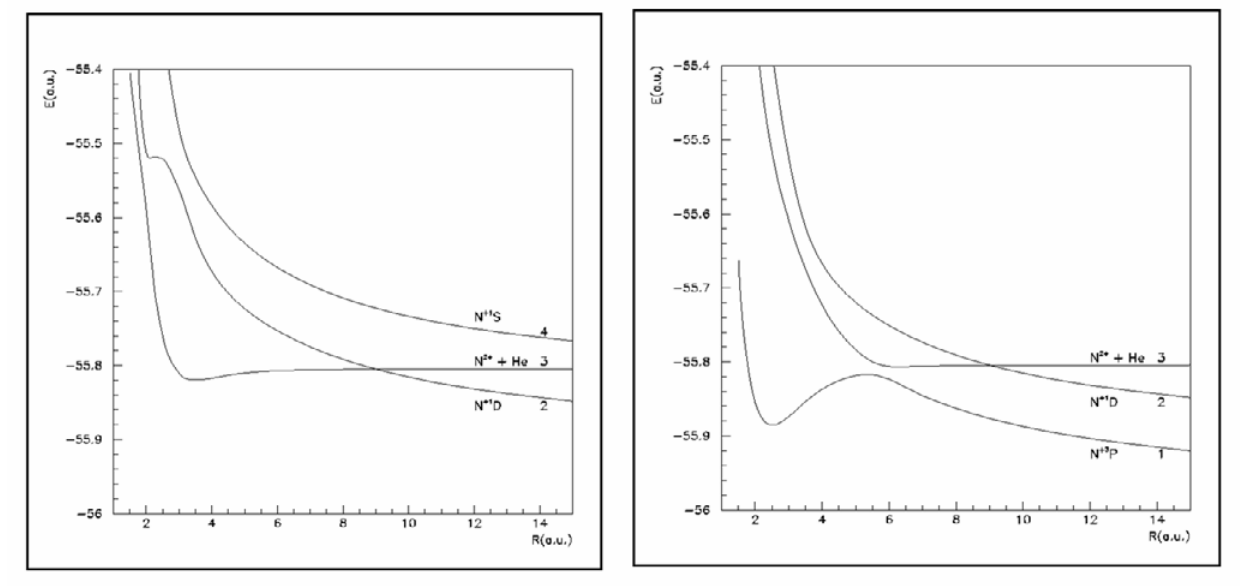
Fig. 1a,b : Adiabatic potential energy curves for respectively the 2 Σ + and 2 Π states of N 2+ + He [22]. 1 : 2 Π state dissociating in N + (2p 2 ) 3 P + He + (1s) ; 2 : 2 Σ and 2 Π states dissociating in N + (2p 2 ) 1 D + He + (1s) ; 3 : entry channel N 2+ (2p) 2 P o + He ; 4 : 2 Σ state dissociating in N + (2p 2 ) 1 S + He +